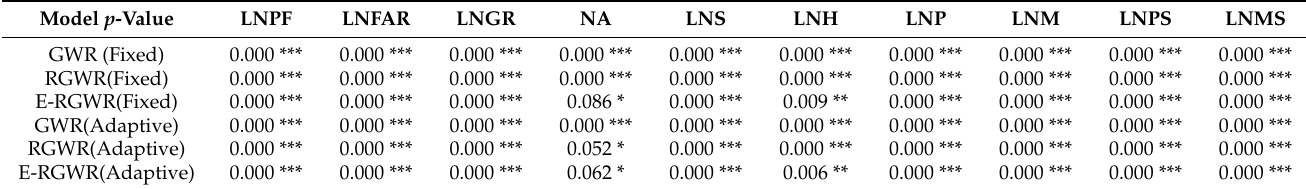
Table 2. The spatial non-stationary characteristic test of the RGWR and GWR